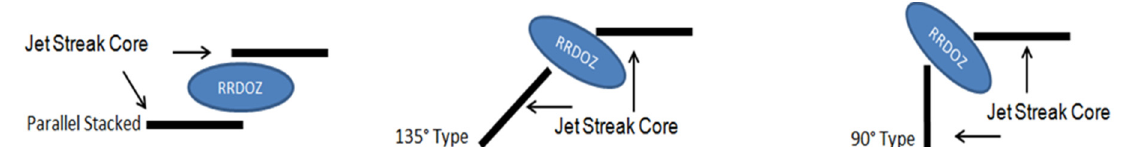
Figure 5. The three archetypes of jet streaks observed in the study .